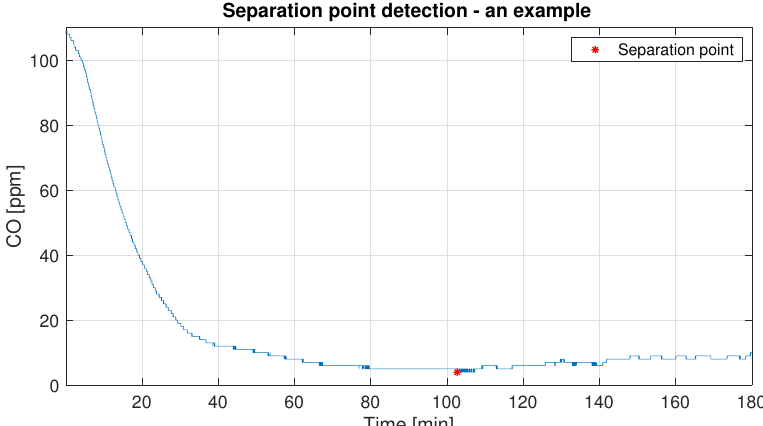
Figure 13. The illustration of the procedure for the separation point location.